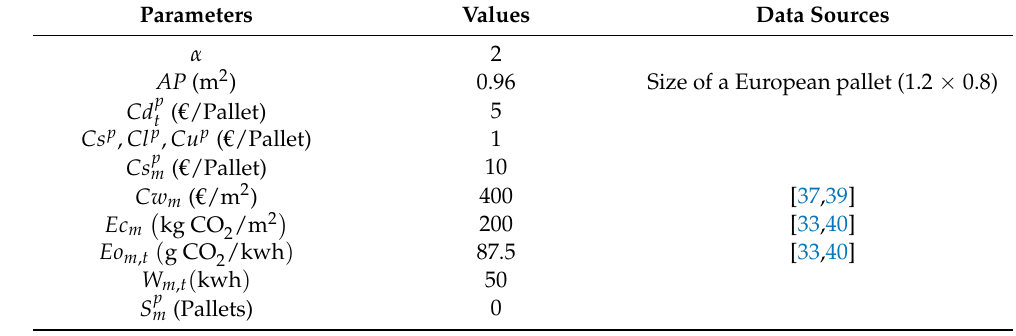
Table 4. Other used data.